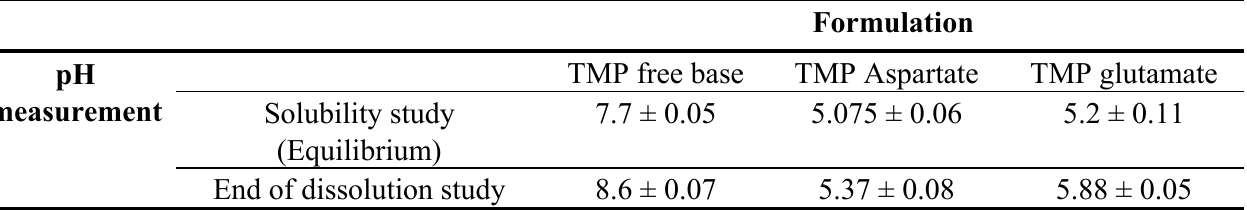
Table 1. pH measurements during solubility and dissolution